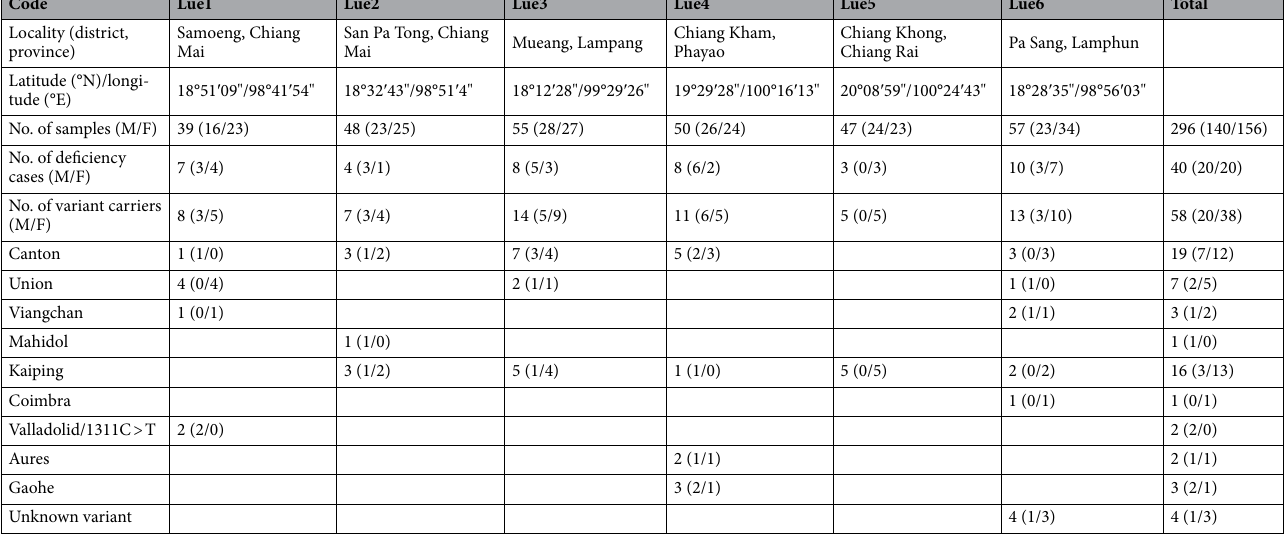
Table 1. General data, G6PD deficiency prevalence and typing of studied